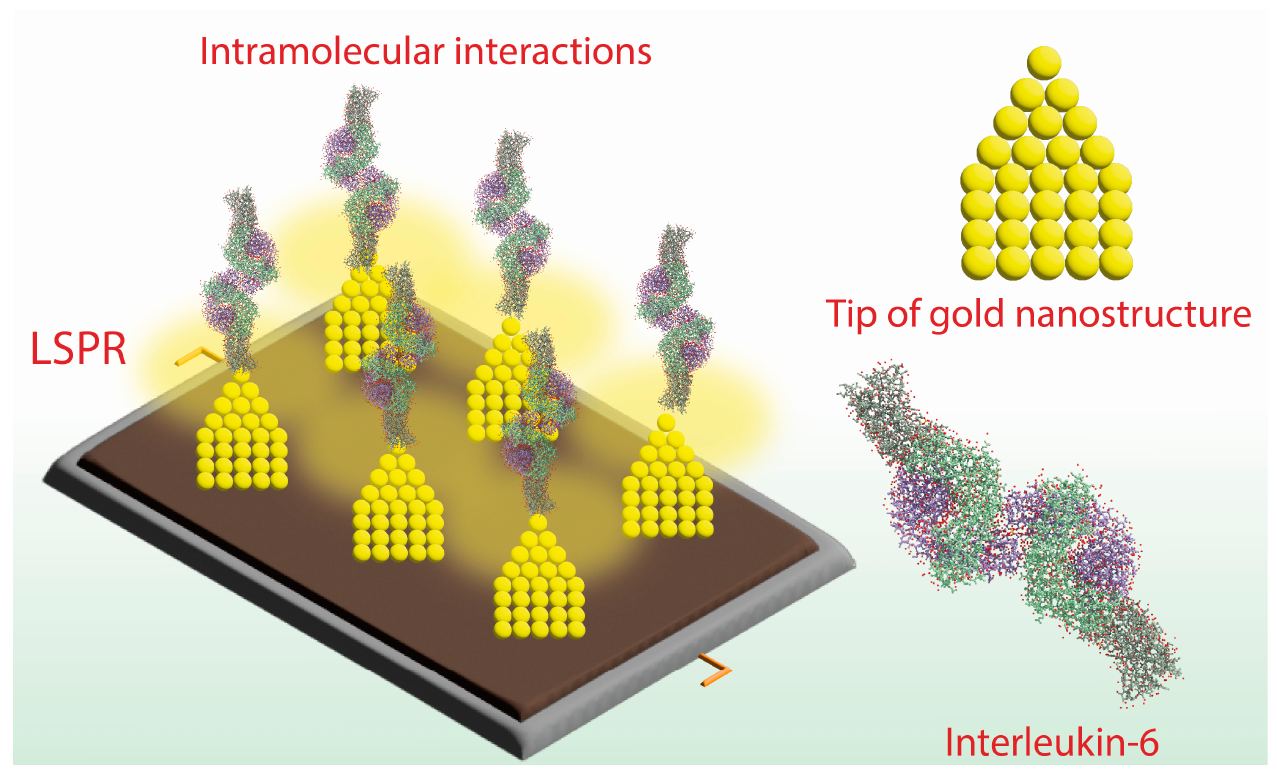
Figure 1. Tip-of-metal nanostructures generate strong LSPR for intramolecular interaction with biomolecules.